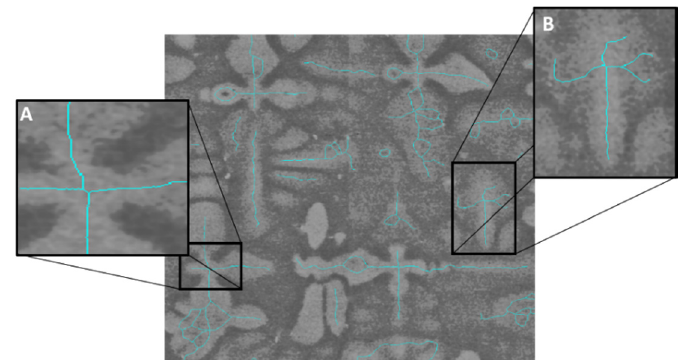
Figure 2. Micrograph with skeletonised dendrites, ( A ) a zoomed-in section of a skewed dendrite core cross and ( B ) a secondary arm representing a dendrite core cross. Image not to scale.